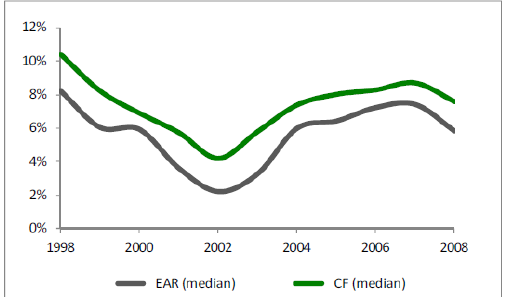
Fig. 3. Relationship between CF and EAR variables in Gandert and Hoydens models (MWBG) in German Stock Exchange